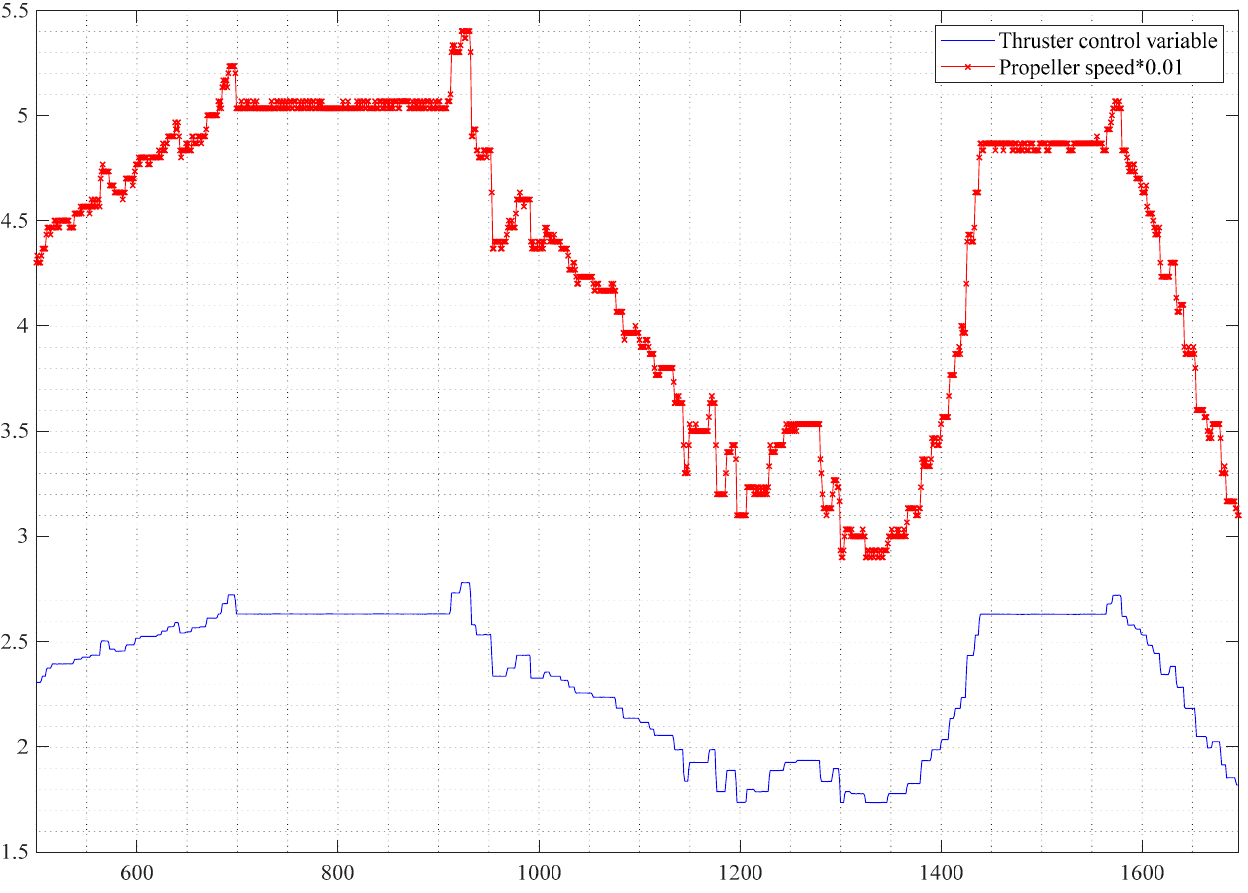
Figure 12. Thruster control variable and propeller speed during pool test of the saucer-shape AUV.